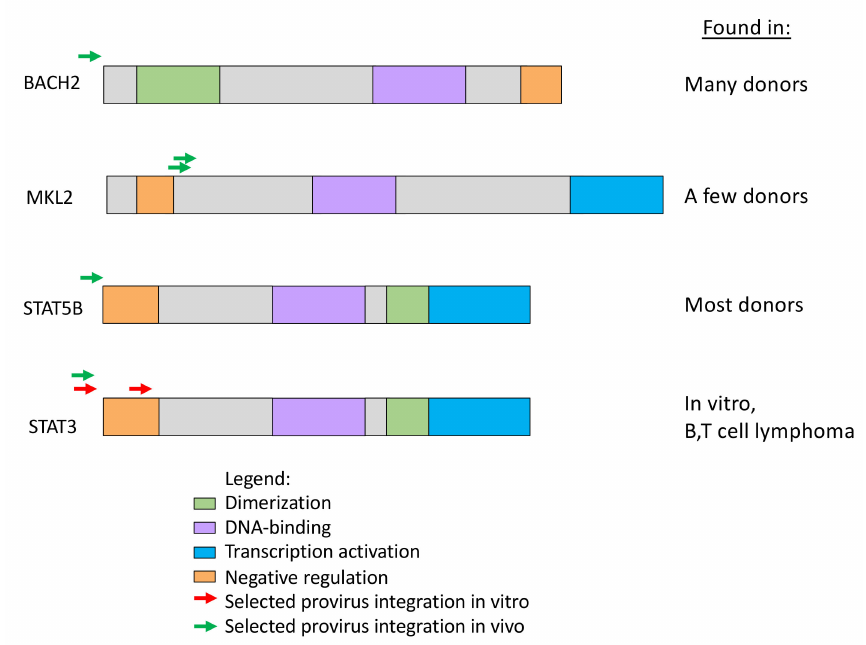
Figure 6. Proviruses in clonally expanded cells can affect the expression of the host gene. The schematic domain organization of the encoded protein products for four genes in which an HIV provirus can provide a selective advantage to the host cell are shown by the colored boxes. Red arrows indicate the orientation and location of selected HIV proviruses in vivo. Note that the STAT3 integration sites are seen amplified only in vitro [58] and in AIDS lymphomas [59]. Provided by Machika